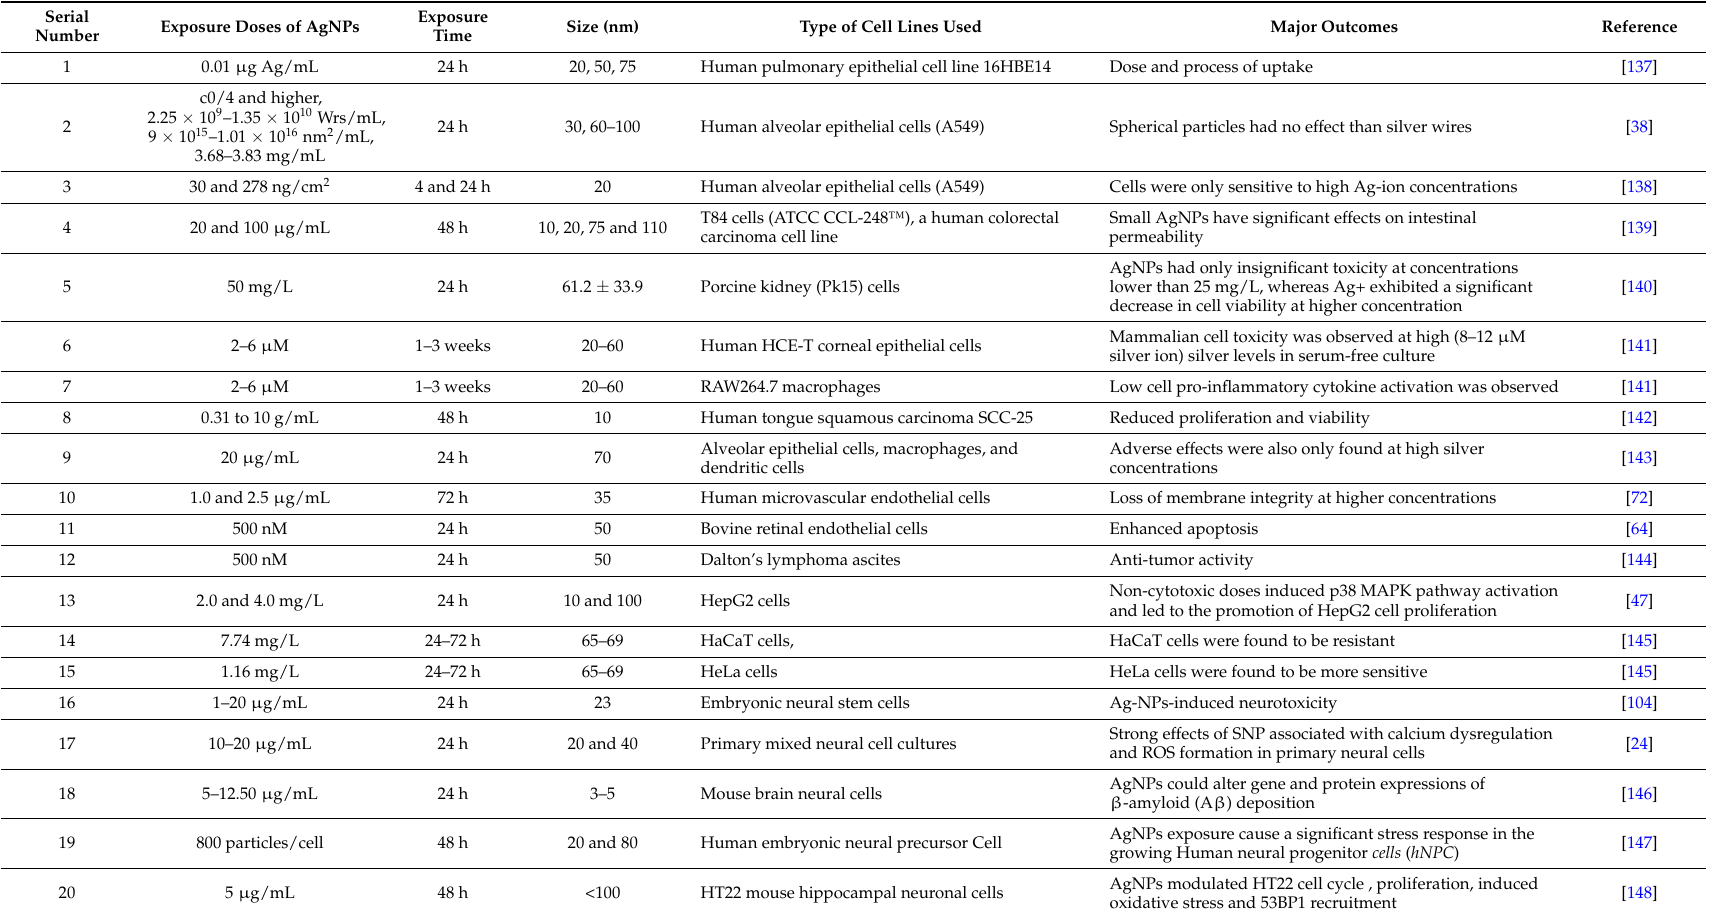
Table 1. The effect of silver nanoparticles (AgNPs) on various cells lines by various concentration, doses, and